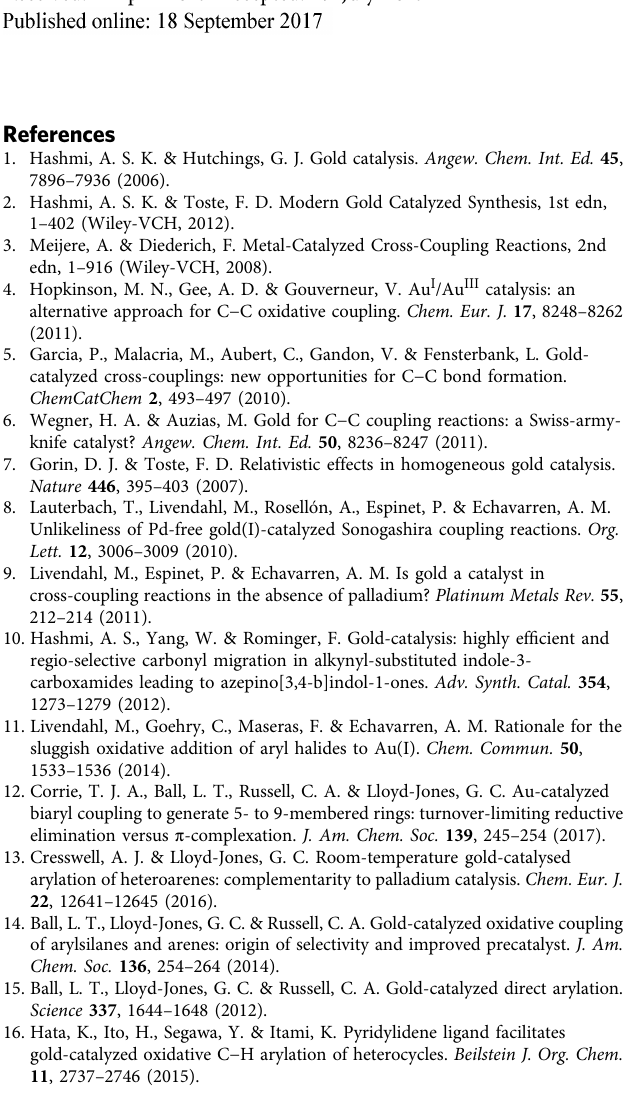
data_request/cif. For computational details and Z -matrices see Supplementary Methods, Supplementary Figs. 49 – 52 and Supplementary Tables 7 – 10. All these data are available from the corresponding authors upon reasonable request.